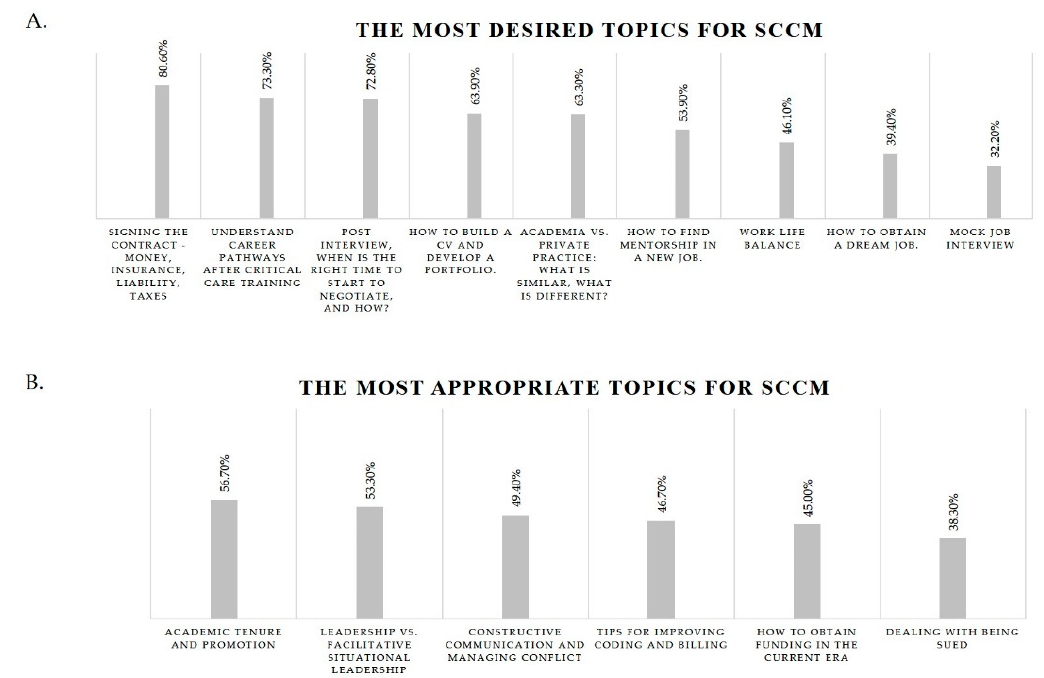
Figure 4. The most desired topics ( A ) and the most appropriate topics ( B ) for discussion at the Society of Critical Care Medicine (SCCM).